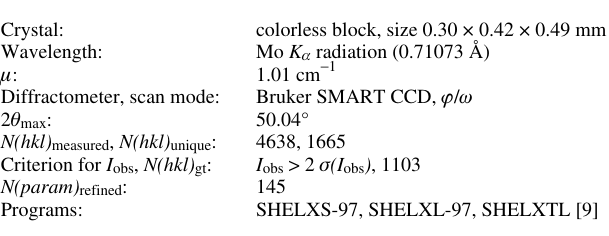
Table 1. Data collection and handling.